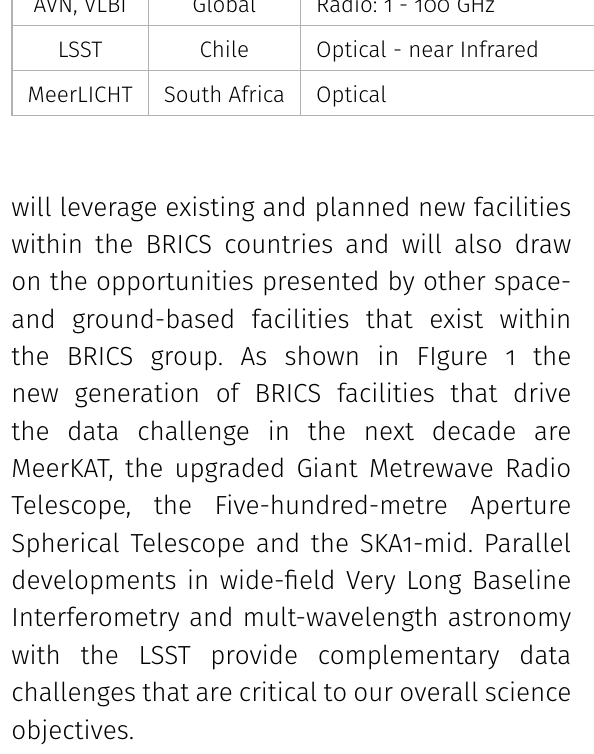
Table I. Current and Planned Facilities providing big data challenges for BRICS Astronomy Research. Telescope Location Wavelengths Data rate SKA1-mid South Africa Radio: 350MHz - 14GHz 1000 TB/day MeerKAT South Africa Radio: 580MHz - 3.5GHz 10-100 TB/day FAST China Radio: 70MHz - 3GHz 690 TB/day uGMRT India Radio: 0.1 - 1.45GHz 10 TB/day PRAO Russia Radio: 111MHz 0.1 TB/day AVN, VLBI Global Radio: 1 - 100 GHz 10 TB/day LSST Chile Optical - near Infrared 20 TB/night MeerLICHT South Africa Optical 0.1